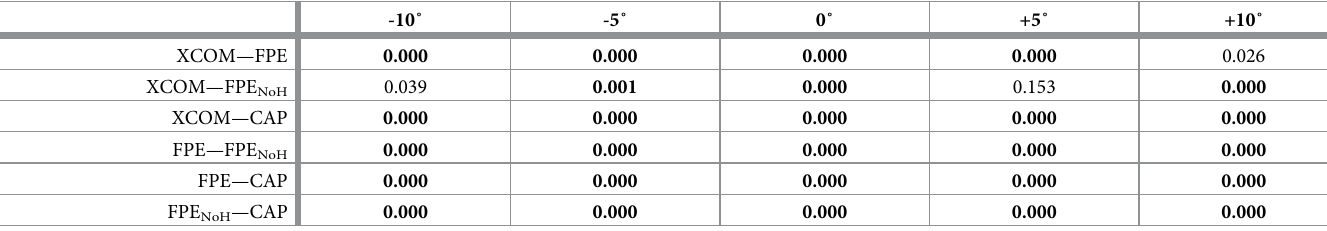
Table 1. p -values from one-sample t -tests of differences between stability metrics. -10˚